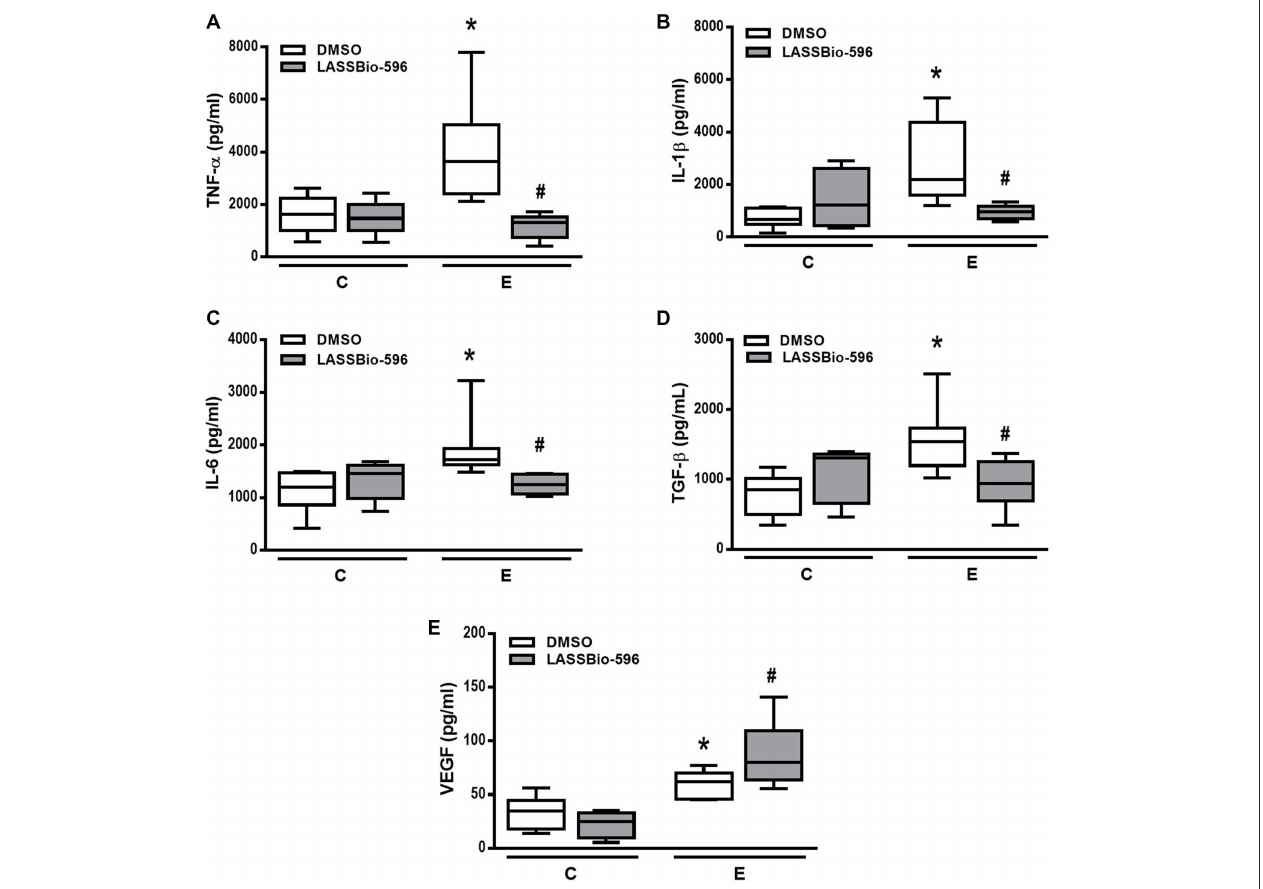
FIGURE 8 | Levels of tumor necrosis factor (TNF)- α (A), interleukin (IL)-1 β (B), IL-6 (C), transforming growth factor (TGF)- β (D) and vascular endothelial growth factor (VEGF) (E) quantified by ELISA in lung tissue. Values are median (interquartile range) of six animals in each group. C-DMSO: mice received intratracheal saline and were treated with DMSO. C-LASSBio-596 mice received intratracheal saline and were treated with LASSBio-596. E-DMSO: mice received intratracheal porcine pancreatic elastase and were treated with DMSO. E-LASSBio-596: mice received intratracheal porcine pancreatic elastase and were treated with LASSBio-596. * Significantly different from respective group C ( p < 0.05 ). # Significantly different from E-DMSO ( p < 0.05 ).